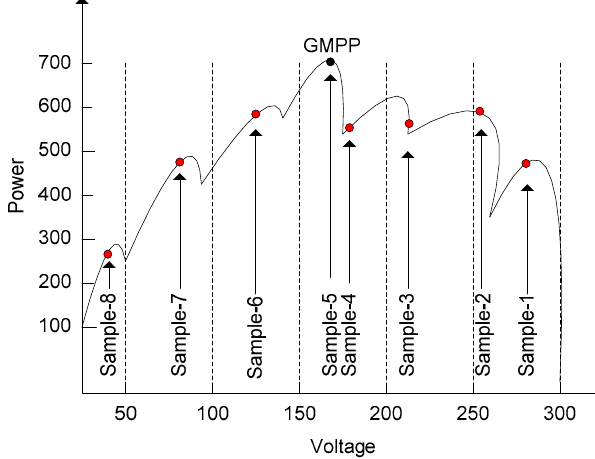
Figure 15. Two-stage segment search method. Abbreviations: GMPP, global maximum power point.